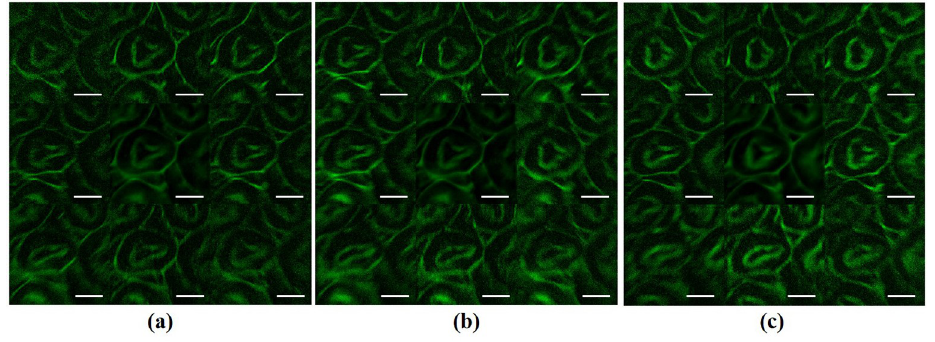
Fig 4. Reconstructed HiLo images from the nine focal planes with different layer spacing: (a) 0.5 μ m; (b) 1.0 μ m; and (c) 1.5 μ m. Scale bar = 15 μ m.